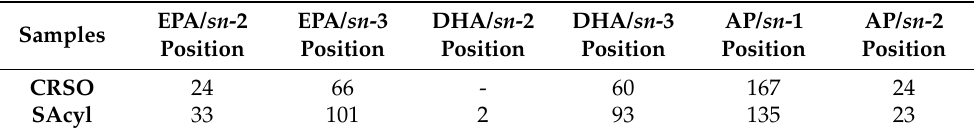
Table 5. Summary of the presence of structures with EPA/DHA in sn -2 and sn- 3 probable positions identified in CRSO and SAcyl optimized